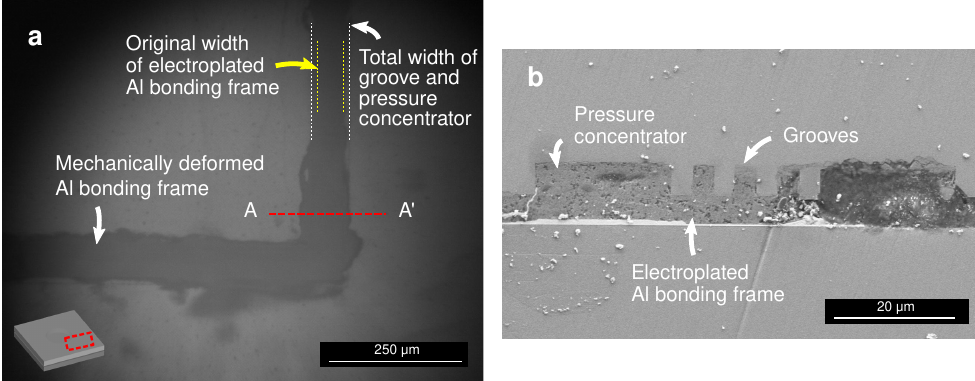
Figure 6. ( a ) Top-view infrared micrograph and ( b ) A-A’ cross-sectional scanning electron micrograph of the bonded